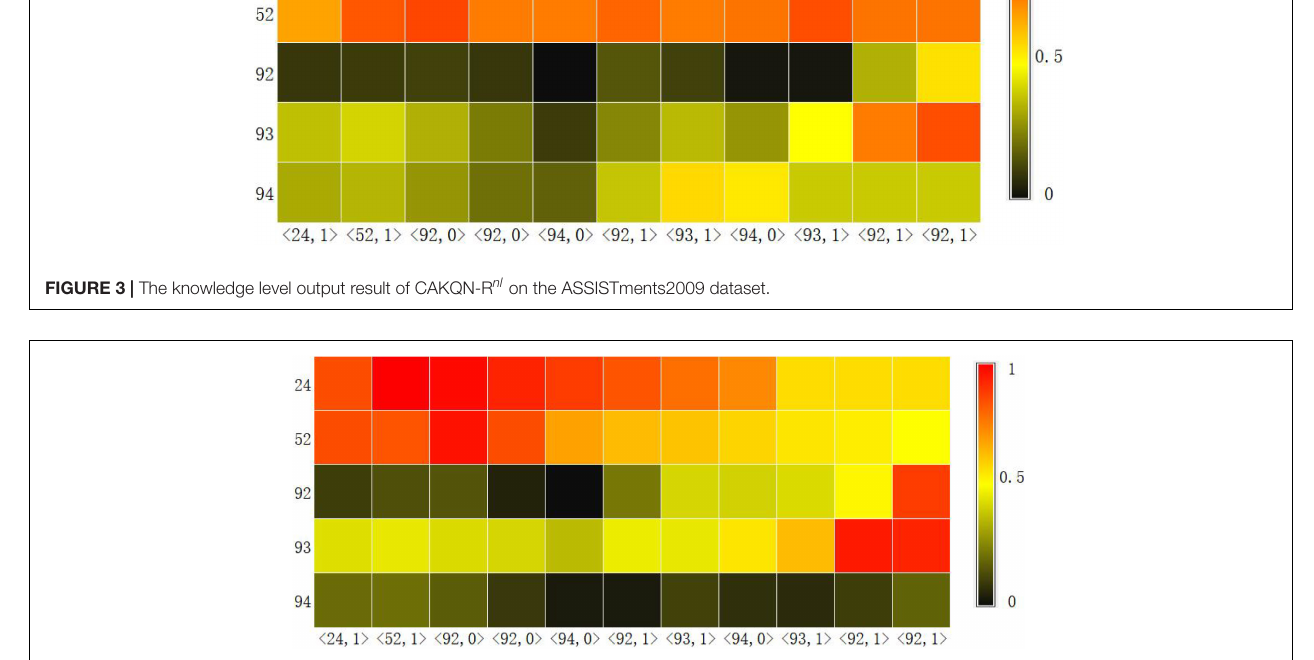
FIGURE 4 | The knowledge level output result of CAKQN-R on the ASSISTments2009 dataset.